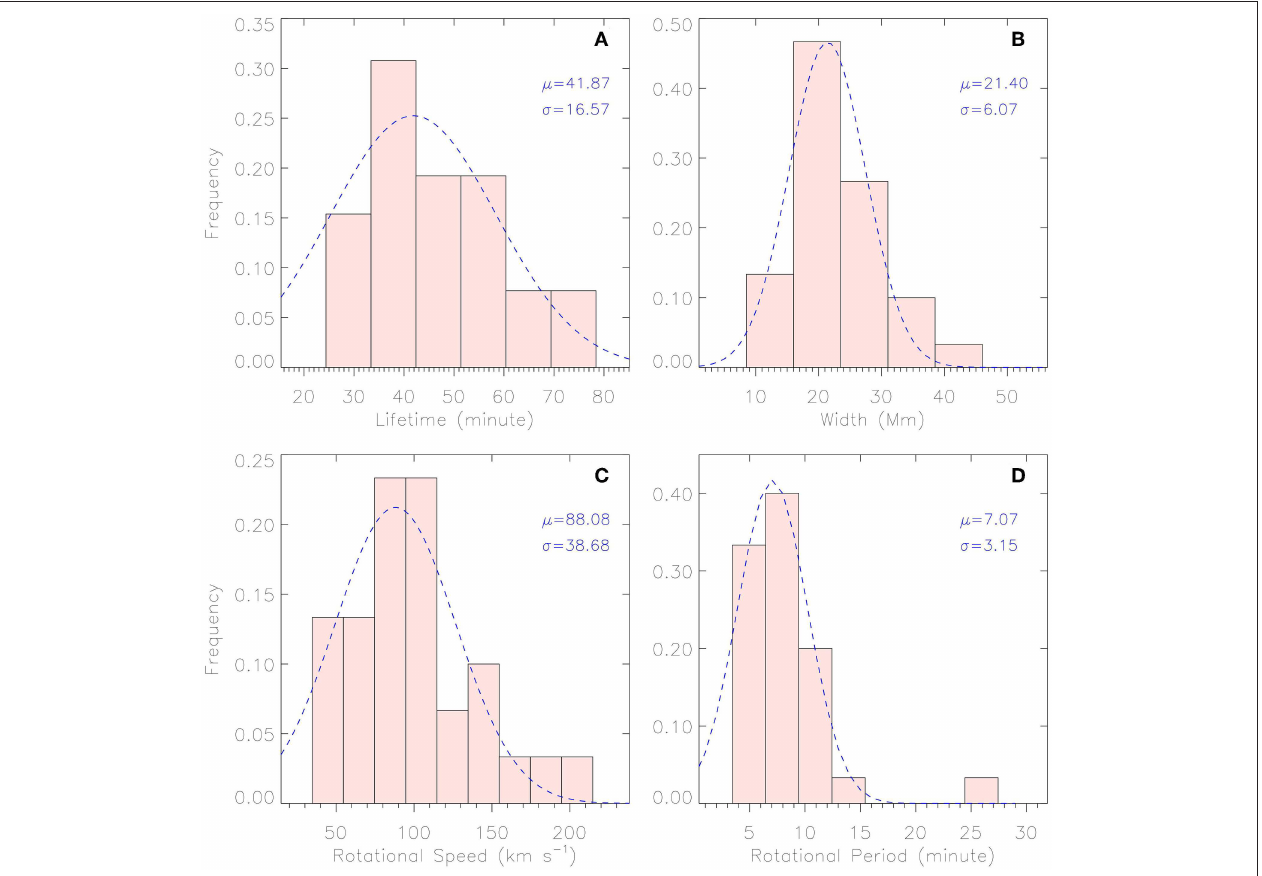
FIGURE 4 | Statistics of the lifetime (A) , average width (B) , rotational speed (C) and rotational period (D) of the studied rotational coronal jets. Blue dashed curves are Gaussian fitting results. µ and σ are the arithmetic mean and standard deviation, respectively.